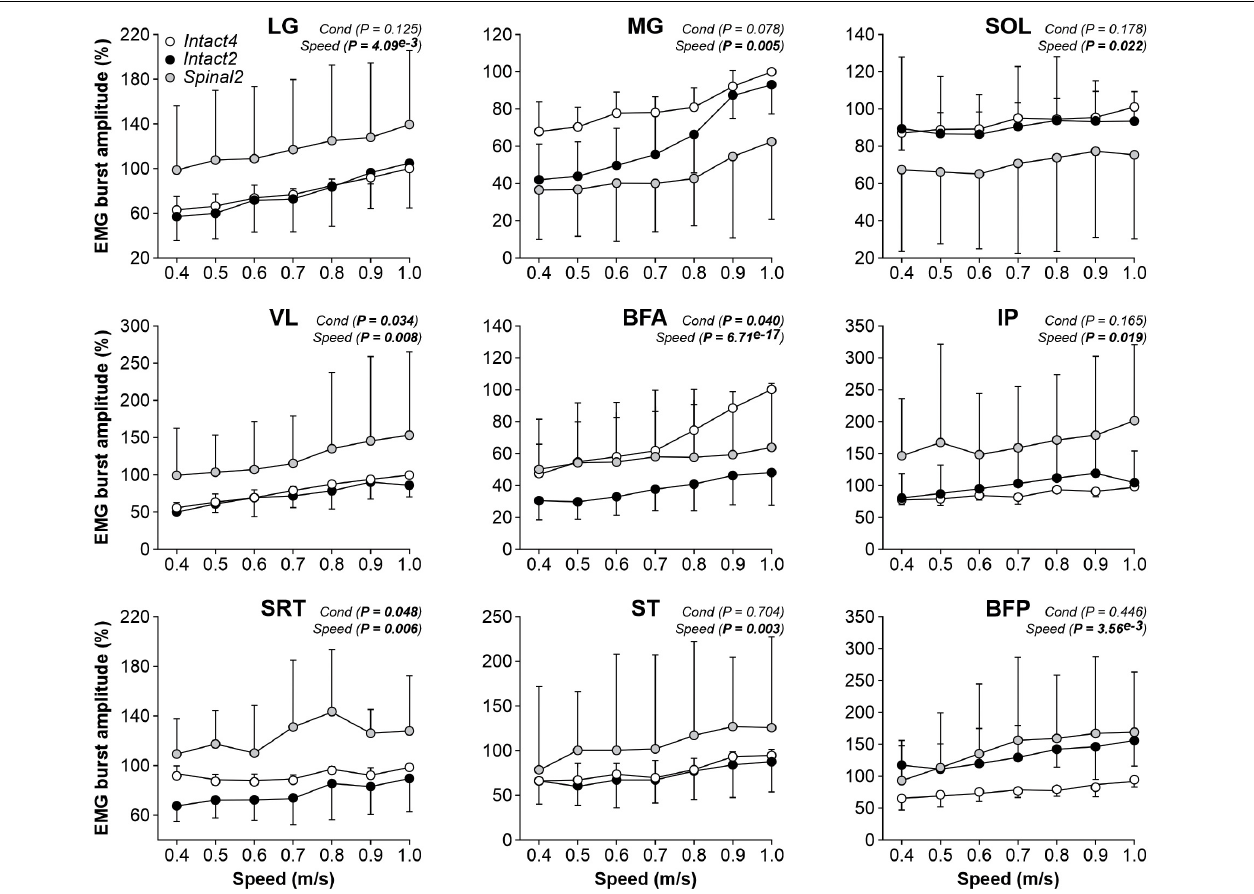
FIGURE 6 | Modulation of EMG burst amplitudes during quadrupedal or hindlimb-only locomotion in intact and spinal cats across speeds. The figure shows burst amplitudes from nine hindlimb muscles during Intact4, Intact2 and Spinal2 conditions at seven treadmill speeds. At each speed, 6–15 cycles were averaged per cat. For each cat, the mean obtained at a given speed in all three conditions was expressed as a percentage of the maximal value obtained in Intact4. Each data point indicates the mean ± SD for the group. P values comparing conditions (Cond) and speeds are indicated (main effects of repeated-measures ANOVA). For muscle abbreviations, see Figure 5